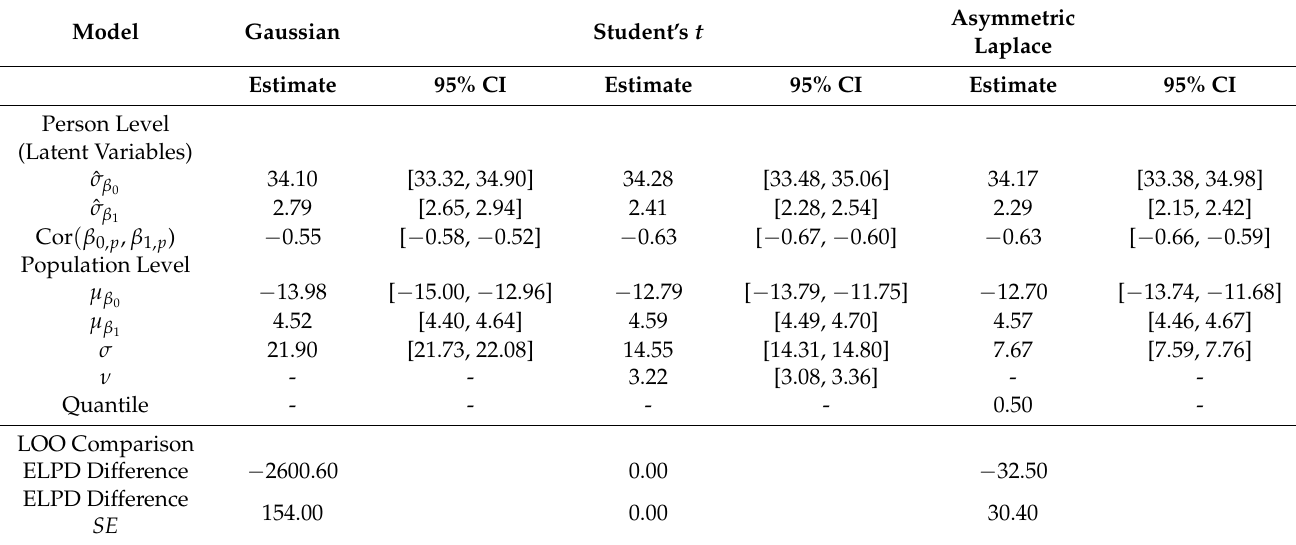
Table 2. Model Estimates and Comparisons for the Latent Growth Curve